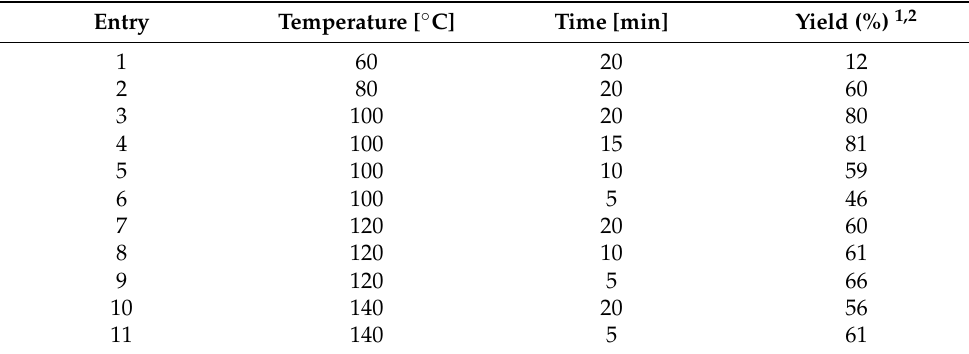
Table 4. Temperature and time screening for Suzuki coupling of 1 with 2